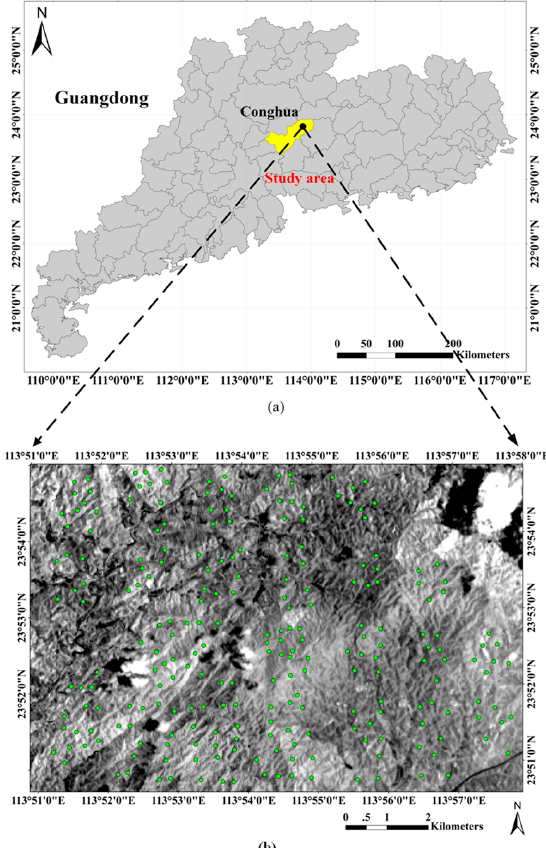
Figure 1. The study area. ( a ) The location of the study area in Conghua, Guangdong province, China; ( b ) Landsat 8 OLI near-infrared image of the study area and the plot positions (green dotts) within the study area.